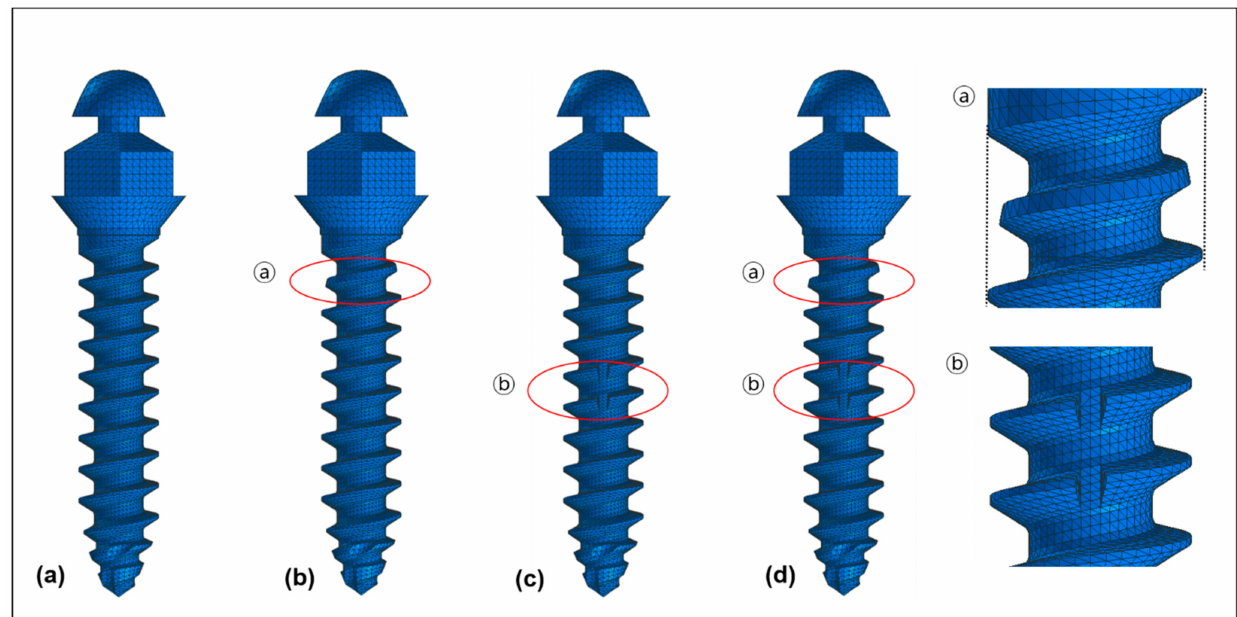
Figure 3. Force loading conditions to measure the rotational resistance of the orthodontic miniscrew: ( a ) Top view of the orthodontic miniscrew with a hole on the head. Yellow arrow indicates the counterclockwise rotating direction to unwind the orthodontic miniscrew; ( b ) Detailed view of two modifications in the threads of the orthodontic miniscrew. Red-col- ored part of the threads were cut additionally for the increase of the resistance. The uppermost part of the threads was narrowed ( ⓐ ), and the vertical notch was added at the middle of the threads at the uppermost part of the threads ( ⓑ ).